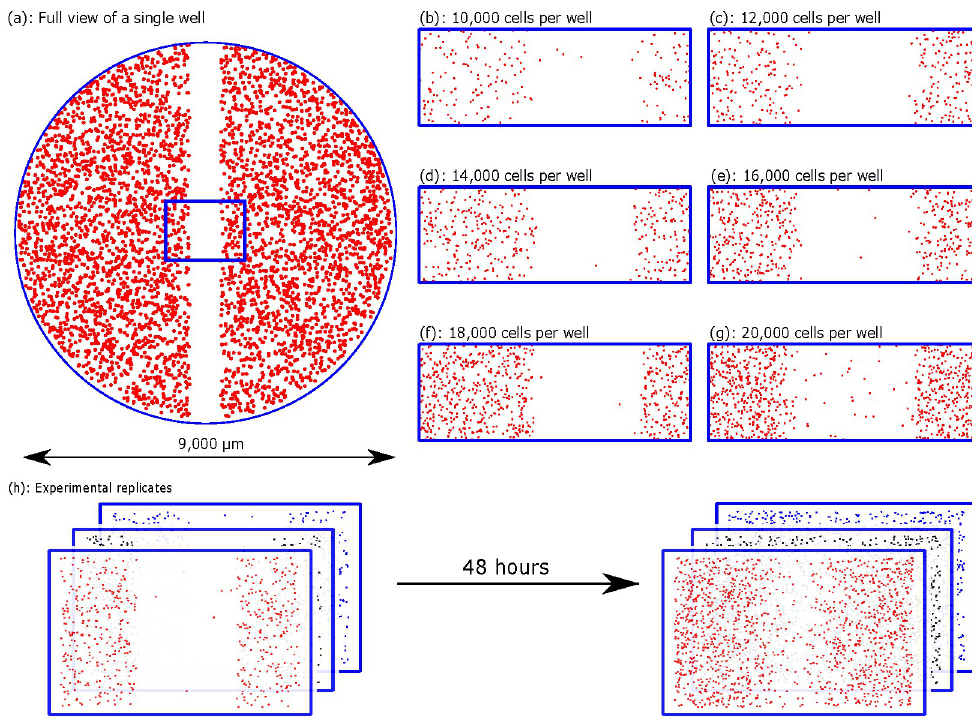
Fig 1. Scratch assay data. Schematics of the scratch assay experiments performed by Jin et al. [13]. (a) A view of a single well. The 1900 μ m wide blue rectangle shows the region where data are imaged and analysed. (b)–(g) Example initial distribution of cells for each initial number of CPW corresponding to the title of each plot. (h) Growth of three initial cell distributions for a single initial CPW, at t = 0 h (left) and t = 48 h (right).